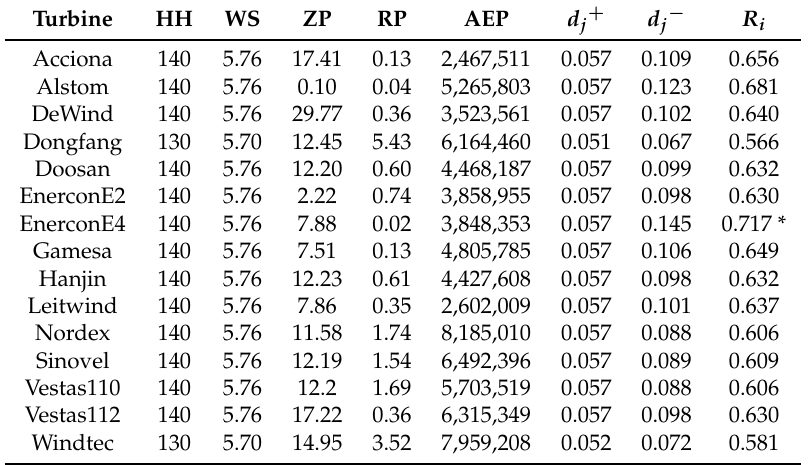
Table 4. Best tradeoff for each turbine for Wejh. The best turbine among all is marked with an asterisk.